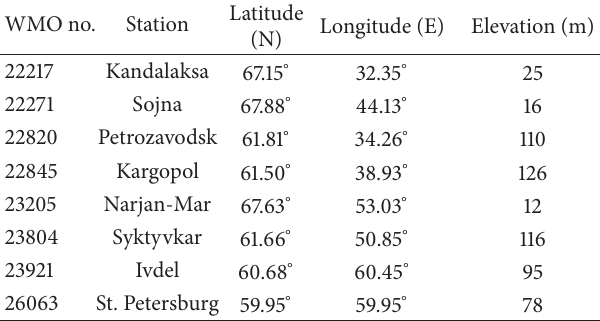
Table 1: Aerological station, whose data used in this work. WMO